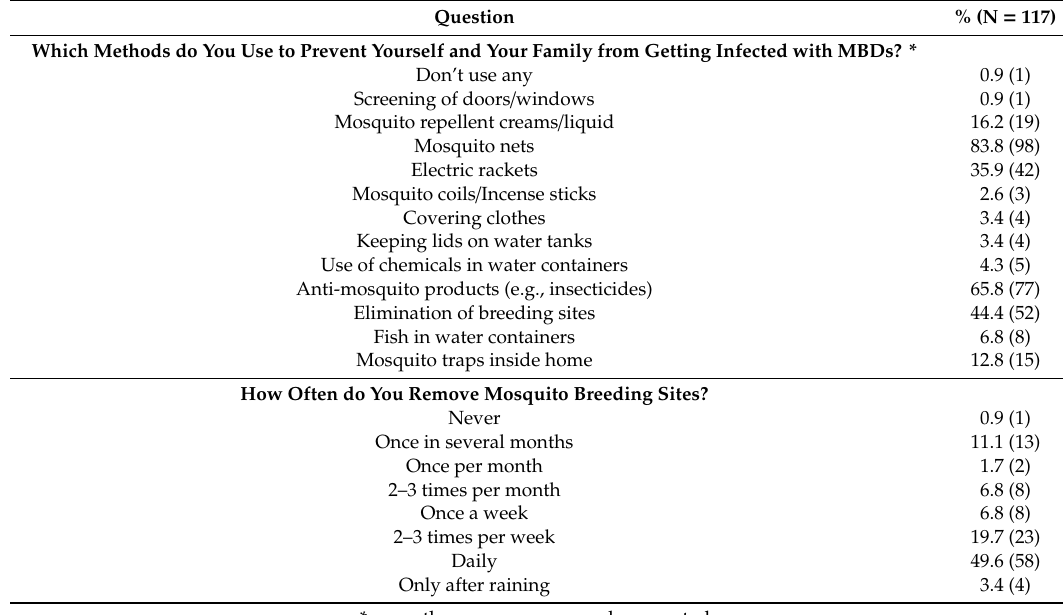
Table 3. Proportion of responses to various questions about practices.